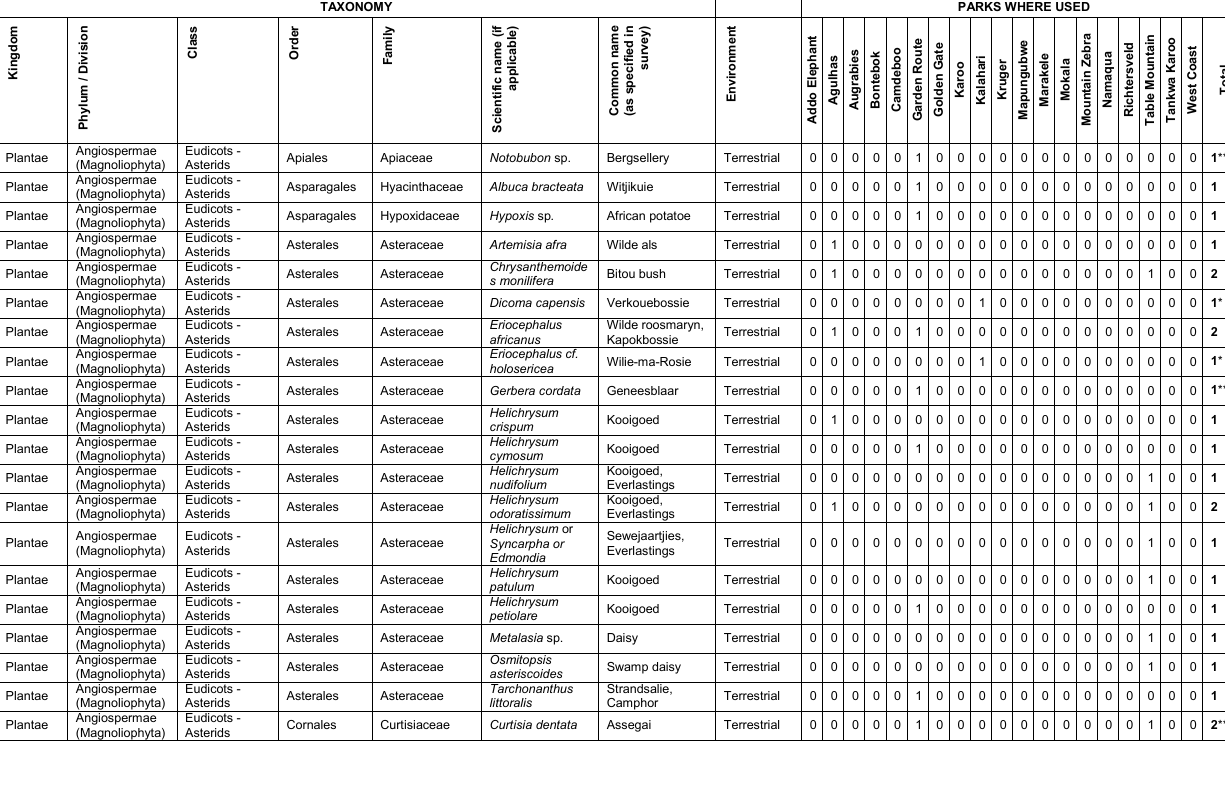
on s i v i D i m / u y l P h